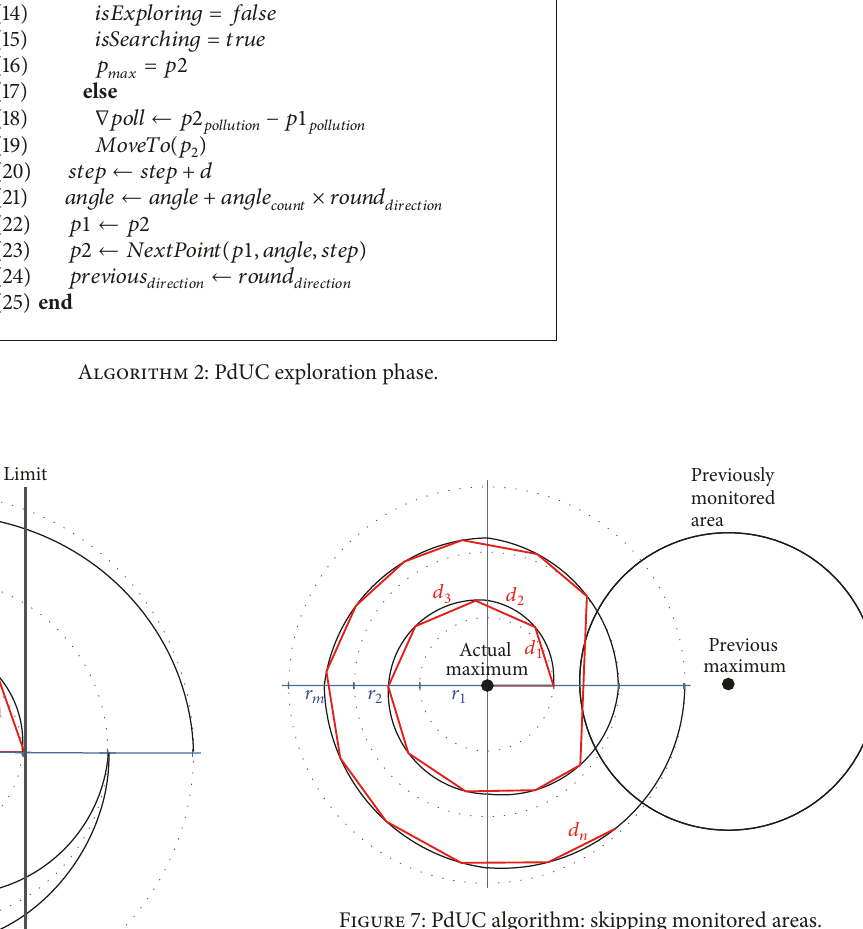
Figure 7: PdUC algorithm: skipping monitored